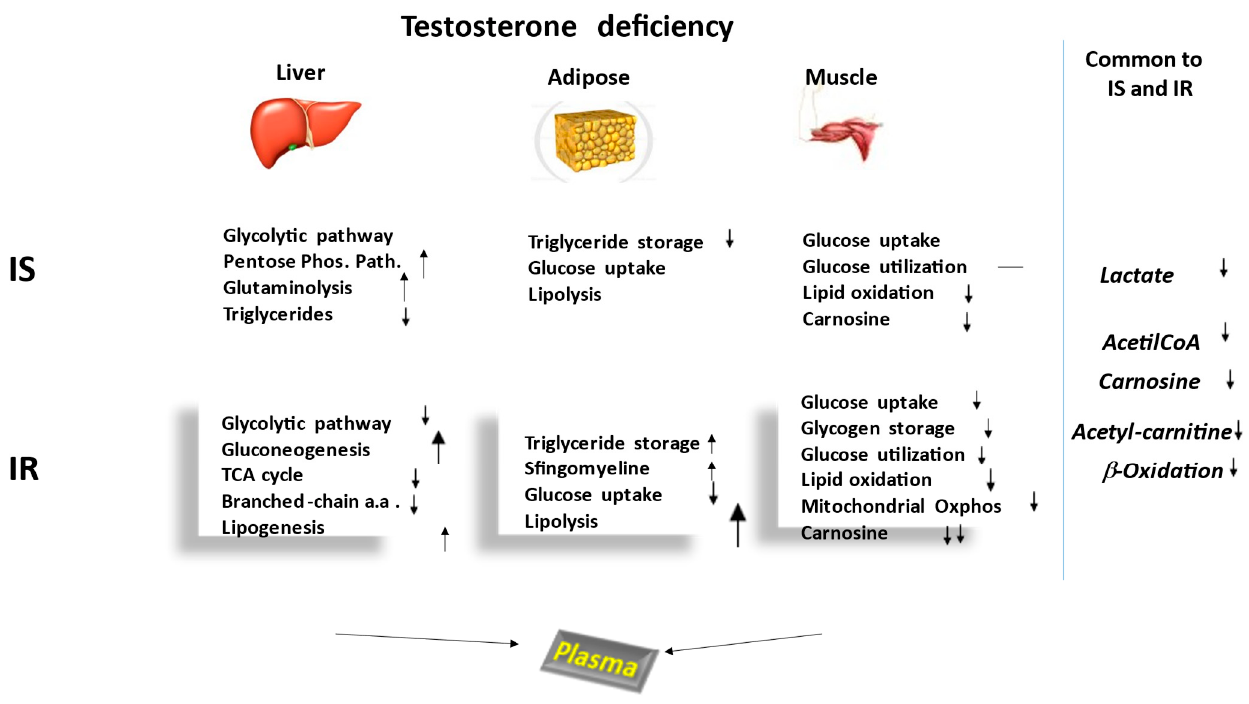
Figure 1. Schematic representation of the metabolisms affected by testosterone deficiency in the three main tissues affected by hypogonadism. Boxes show the metabolisms notoriously altered by testosterone deficiency, the arrows indicating increases or decreases, as well as alterations in terms of intensity. This figure also shows that plasma from a male with hypogonadism is the biofluid in which the metabolites are passively excreted from all other tissues.